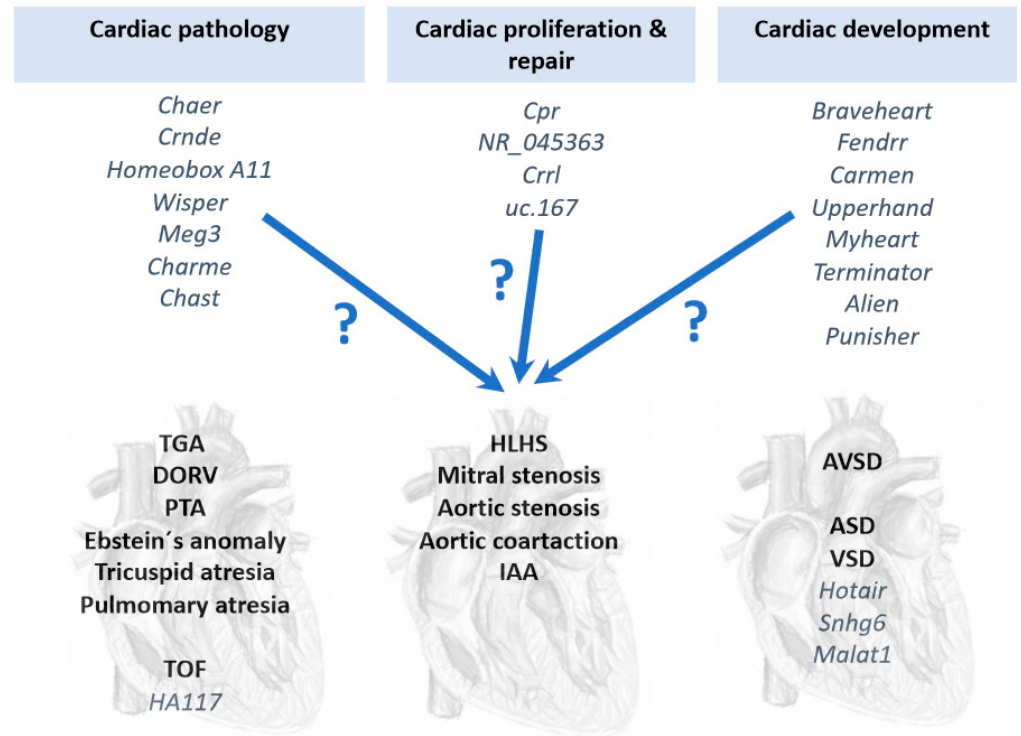
Figure 2. Schematic representation of distinct lncRNAs involved cardiac pathology, cardiomyocyte cell proliferation and repair and cardiac development, which might have functional contribution to CHD. At present, only a minor subset of lncRNAs have been associated to CHD, particularly HA117 in TOF and Hotair, Sngh6 and Malat1 in